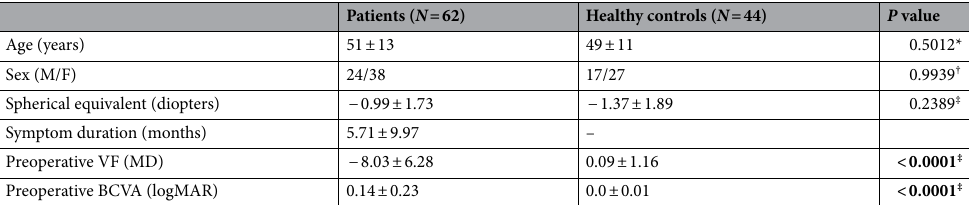
Table 1. Baseline characteristics of patients with chiasmal compression preoperatively and healthy controls. Significant values are indicated in bold. N numbers, M male, F female, VF visual field, MD mean deviation, BCVA best-corrected visual acuity. * P value by Student’s t-test. † P value by Chi-squared test. ‡ P value by Wilcoxon rank sum test.